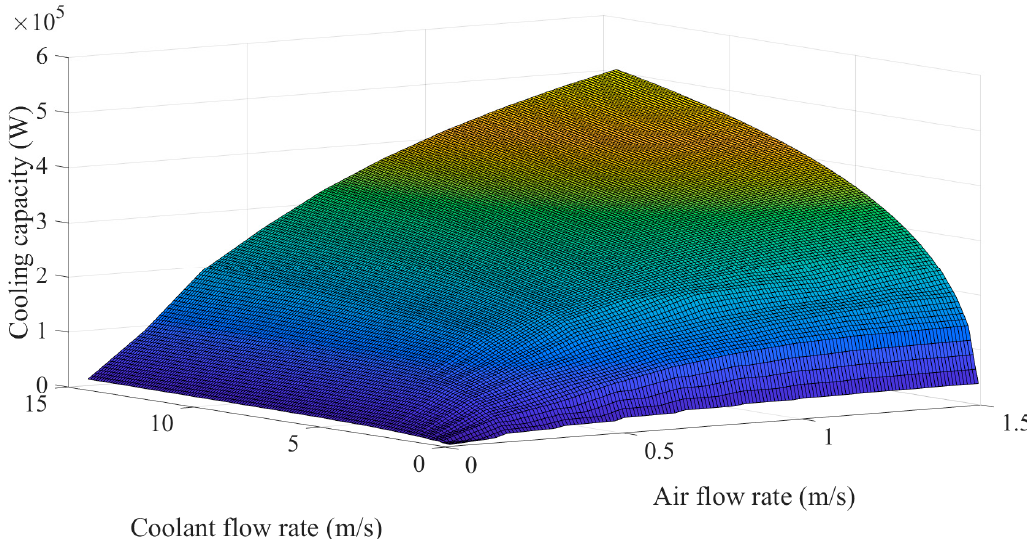
Figure 6. The LUT of the radiator.